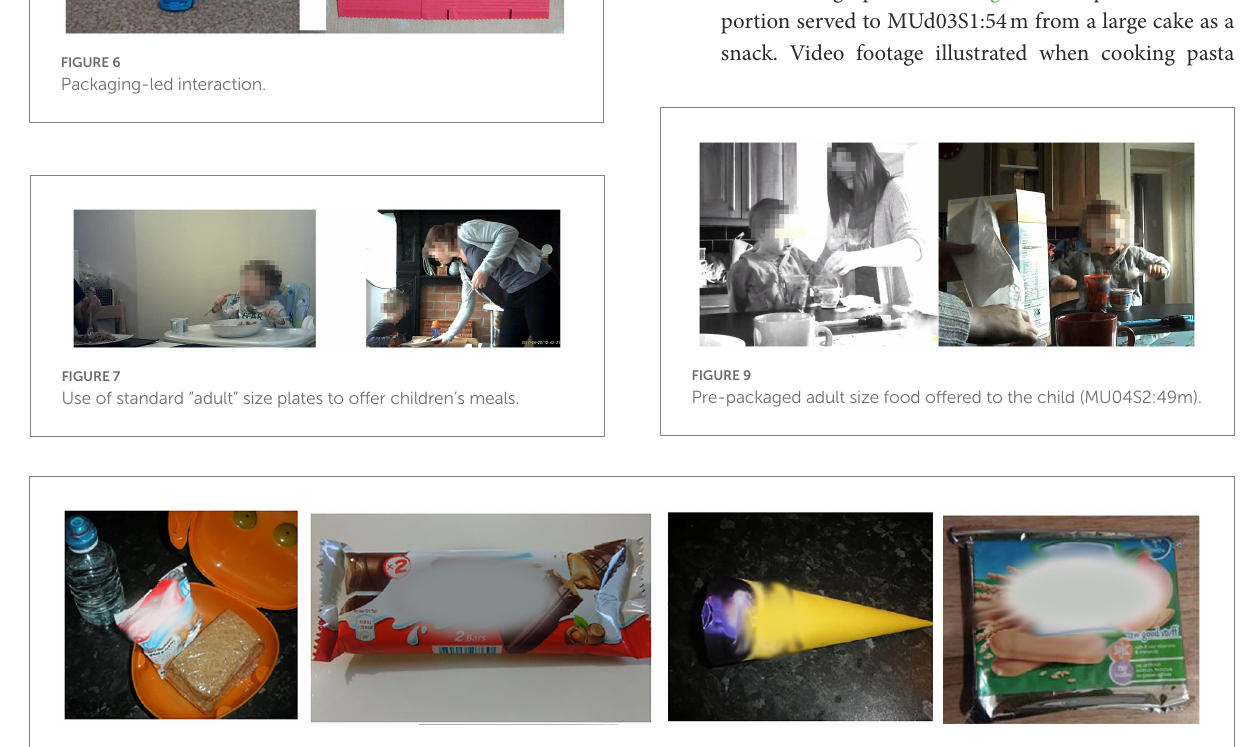
FIGURE 8 Pre-packaged snacks served to children. (1) MU01S1:48 m, (2) MUd03S:54 m, (3) MU01S1:48 m, and (4) MU03S:36 m.